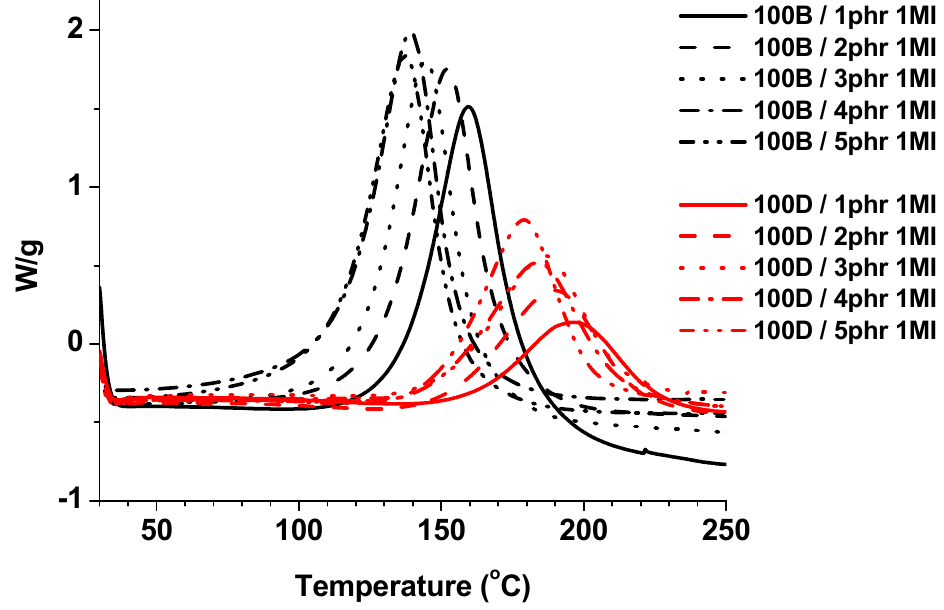
Figure 2. Calorimetric curves corresponding to the curing of ELO with different thiols using 1MI as catalyst.